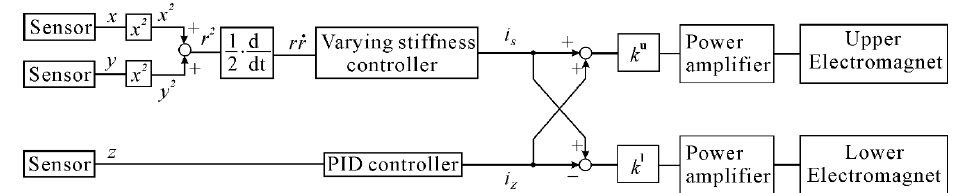
Figure 4. Block diagram of modal control.